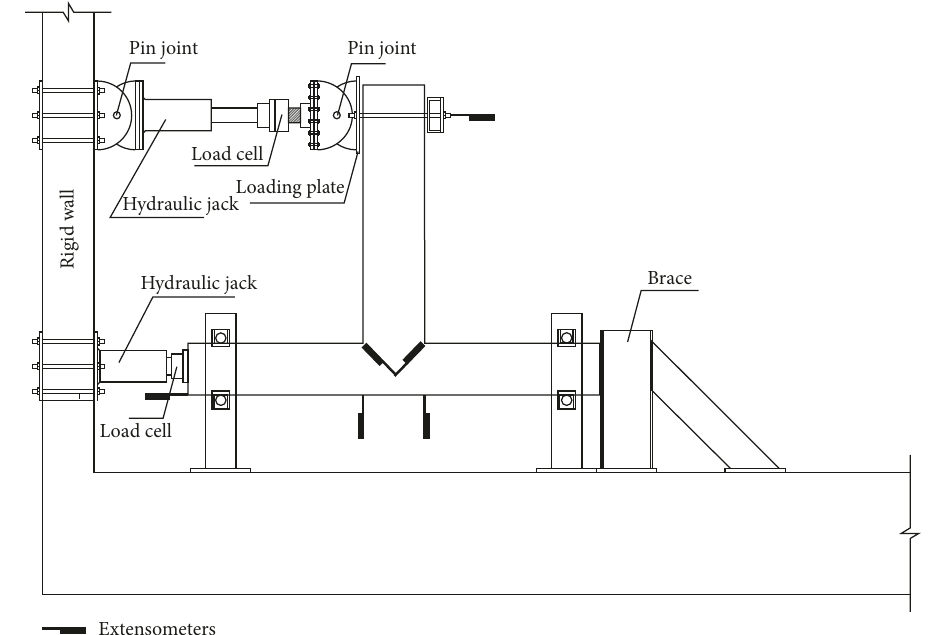
Figure 6: Schematic testing configuration.